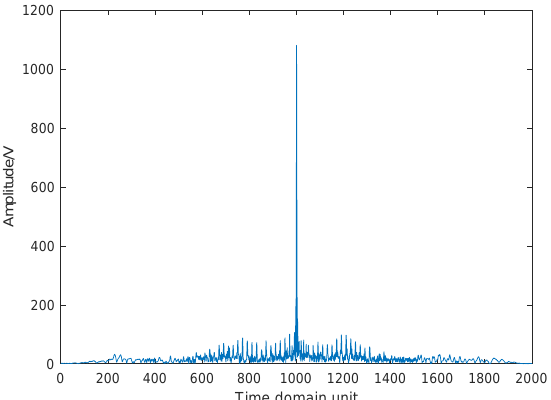
Figure 15. Matched filtering output of the compensated